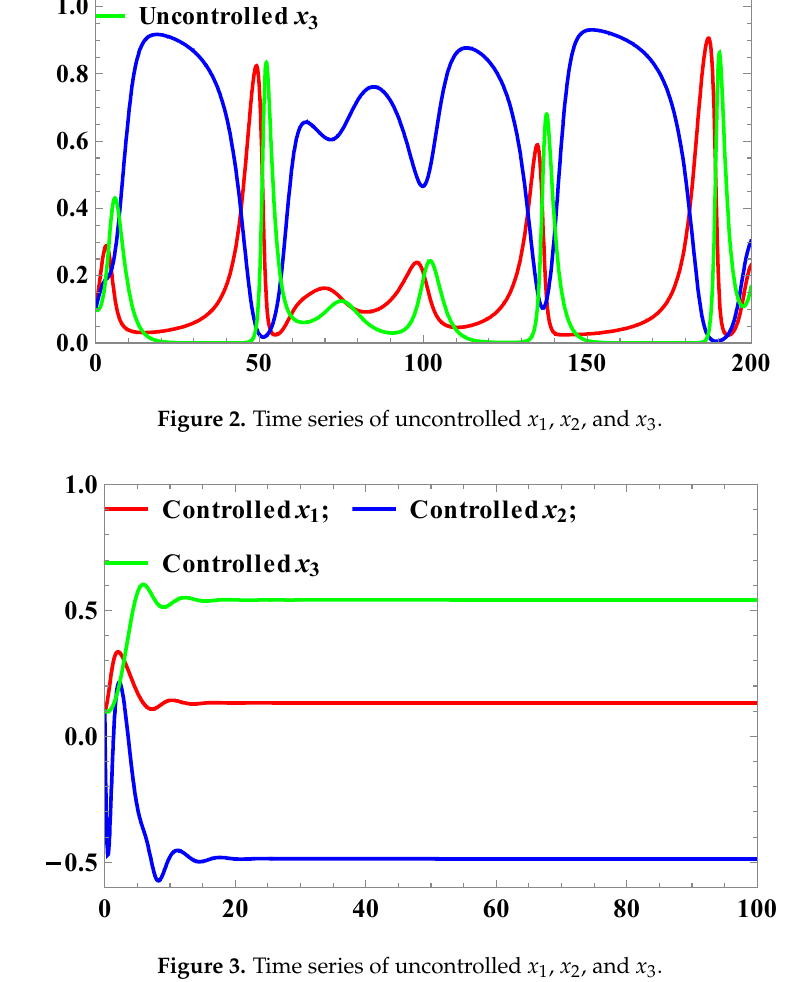
Figure 4. Phase plots of x 1 .